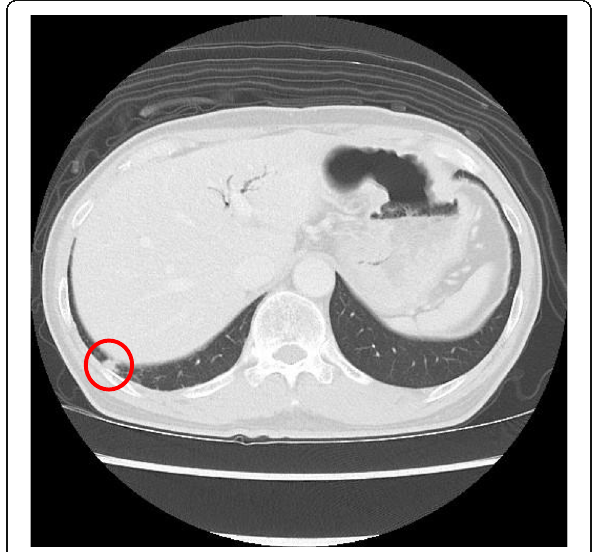
eighth edition UICC classification system criteria.